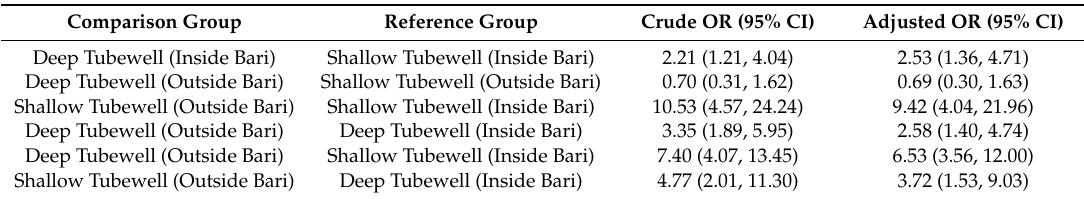
Table 2. Odds Ratios (OR) comparing the use of surface water while washing drinking-water storage containers by tubewell and ownership